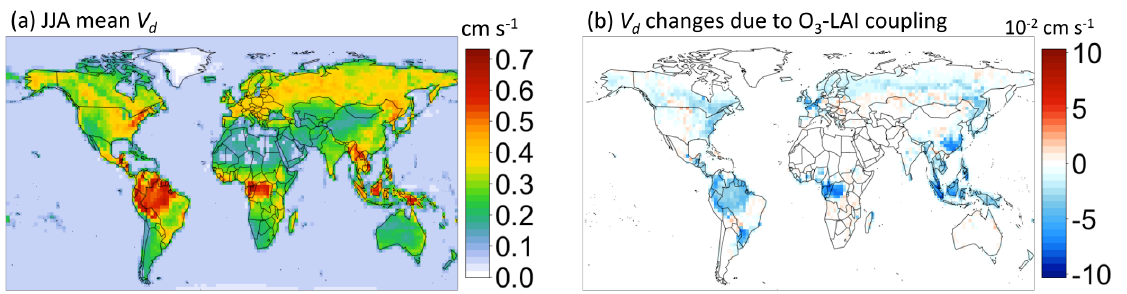
Figure 4. (a) Ozone dry deposition velocity ( v d ) in summer (JJA mean) from the Affected_LAI case, and (b) differences in ozone dry deposition velocity between the Affected_LAI and Intact_LAI case (i.e., Affected_LAI –